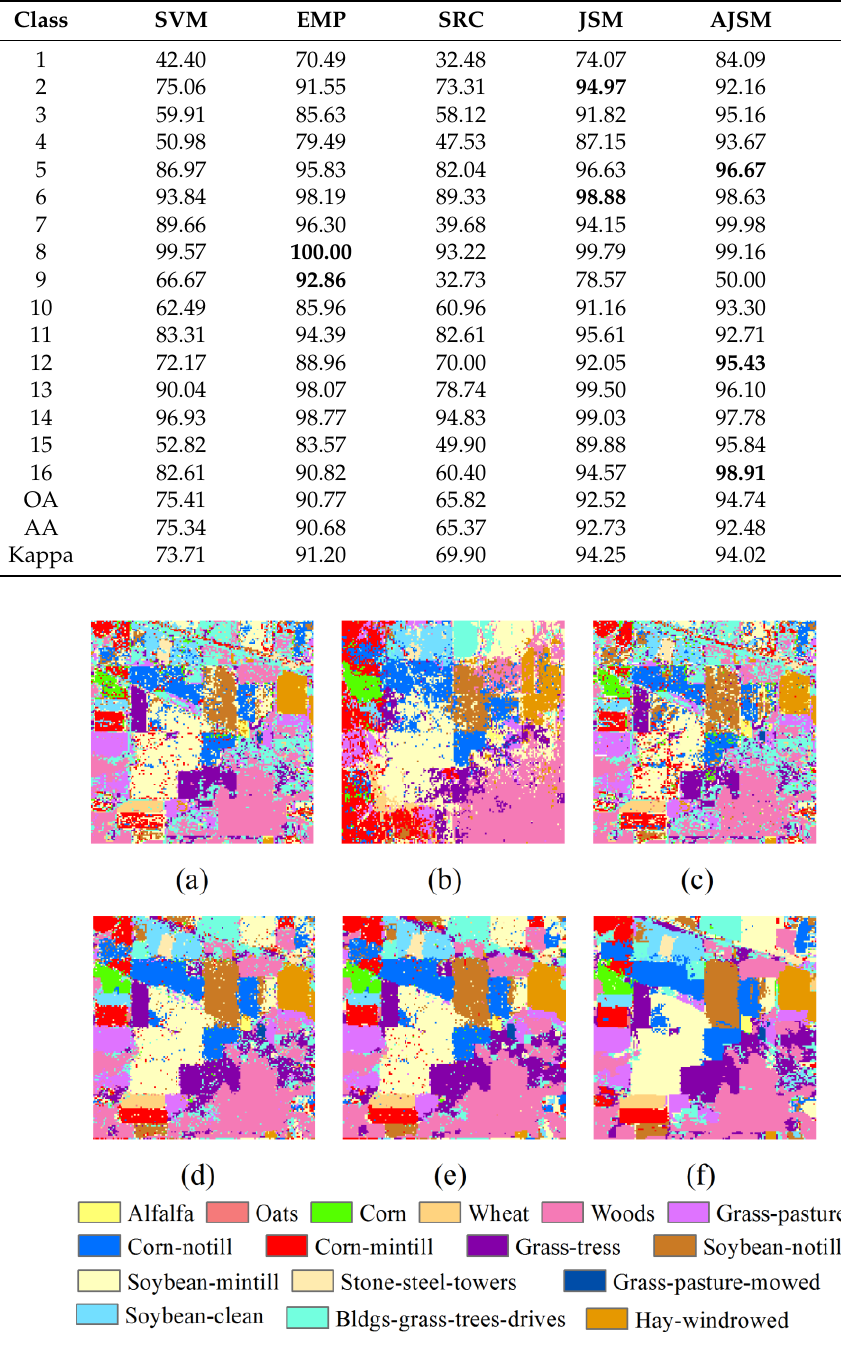
Table 3. Class information for the University of Pavia image. Class No.